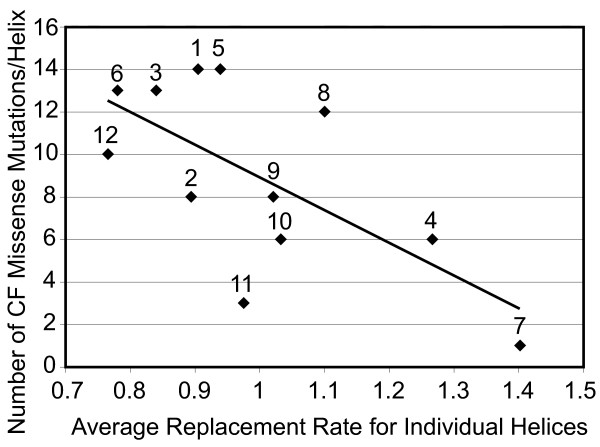
Correlation of the number of missense mutations versus the average replacement rate for the individual alpha helical transmembrane region hosting the corresponding mutations. Transmembrane helices 1–12 are numbered.